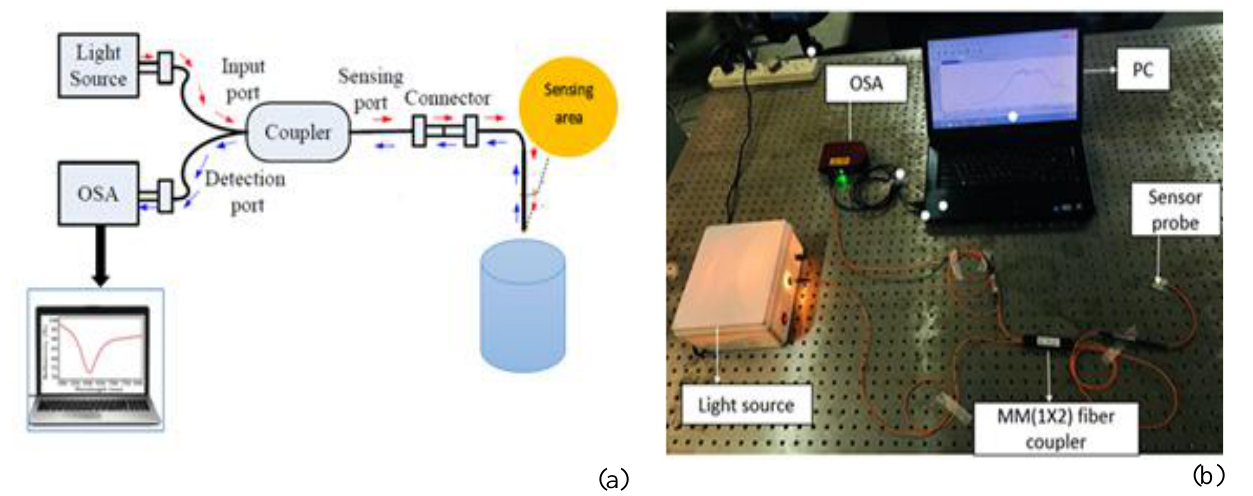
Figure 5. (a) The schematic experimental setup system; (b) image of an experimental setup SPR optical fiber 4.